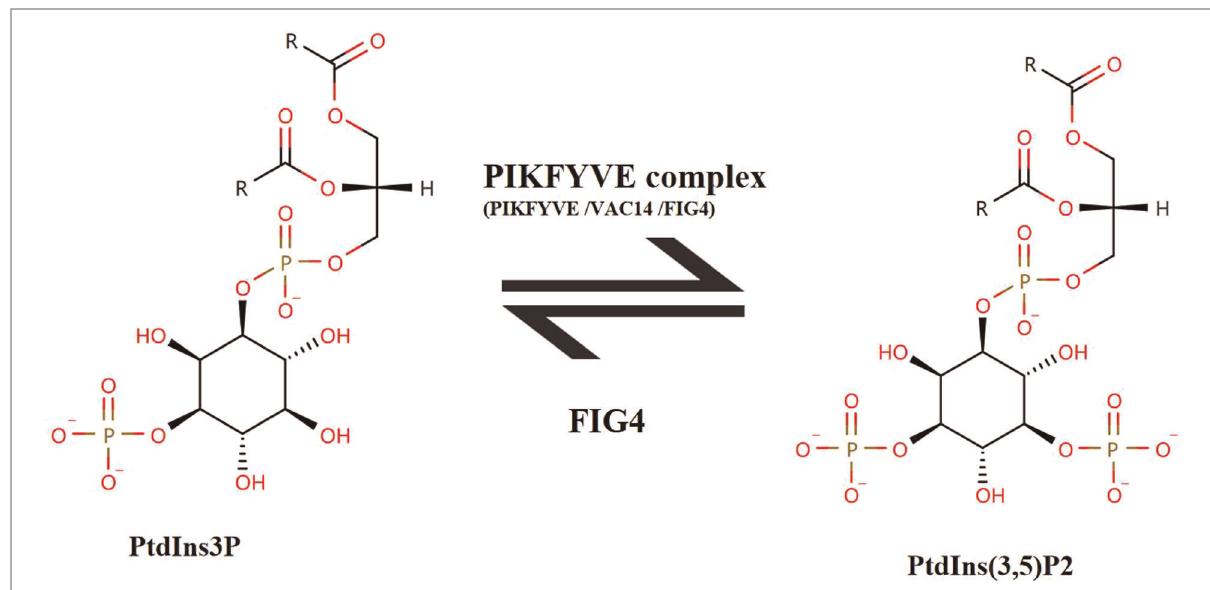
FIGURE 6 The transition between PtdIns(3,5)P2 and PtdIns3P. FIG4 catalyzes the dephosphorylation of PtdIns(3,5)P2 to form PtdIns3P. PIKFYVE complex consists of three subunits (PIKFYVE, VAC14, FIG4). PIKFYVE is the sole enzyme that catalyzes the phosphorylation of PtdIns3P on the fi fth hydroxyl of the myo-inositol ring to form